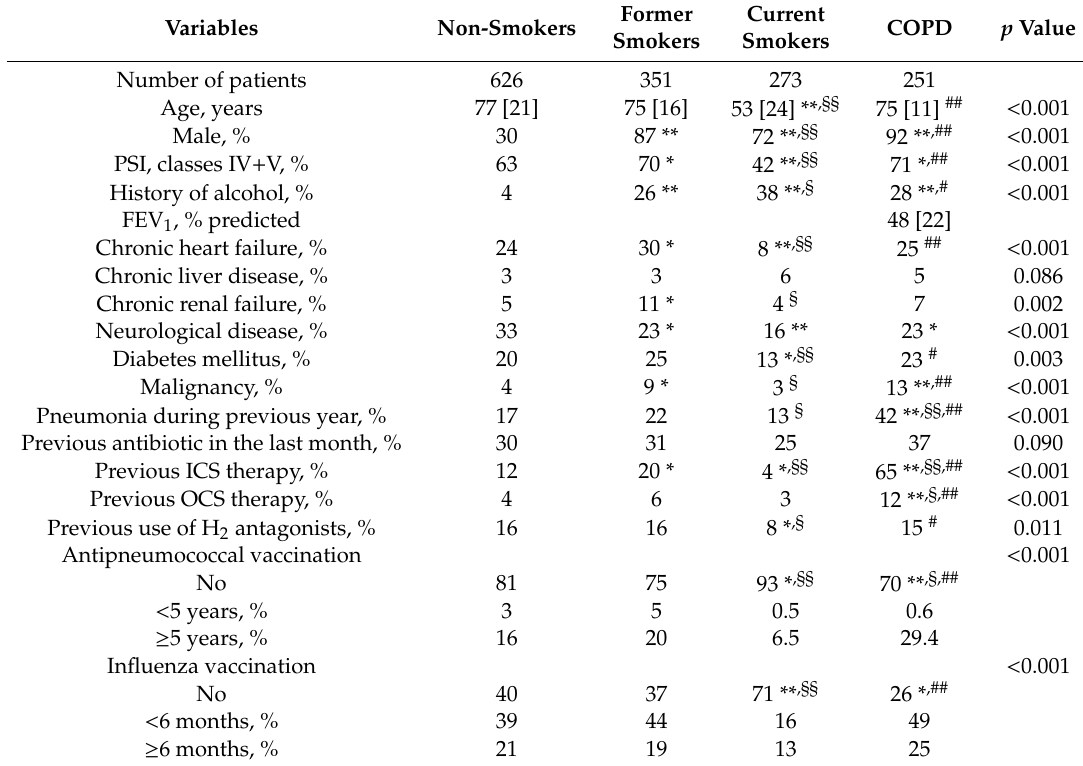
Table 1. Baseline characteristics of patients with CAP by smoking habit and COPD